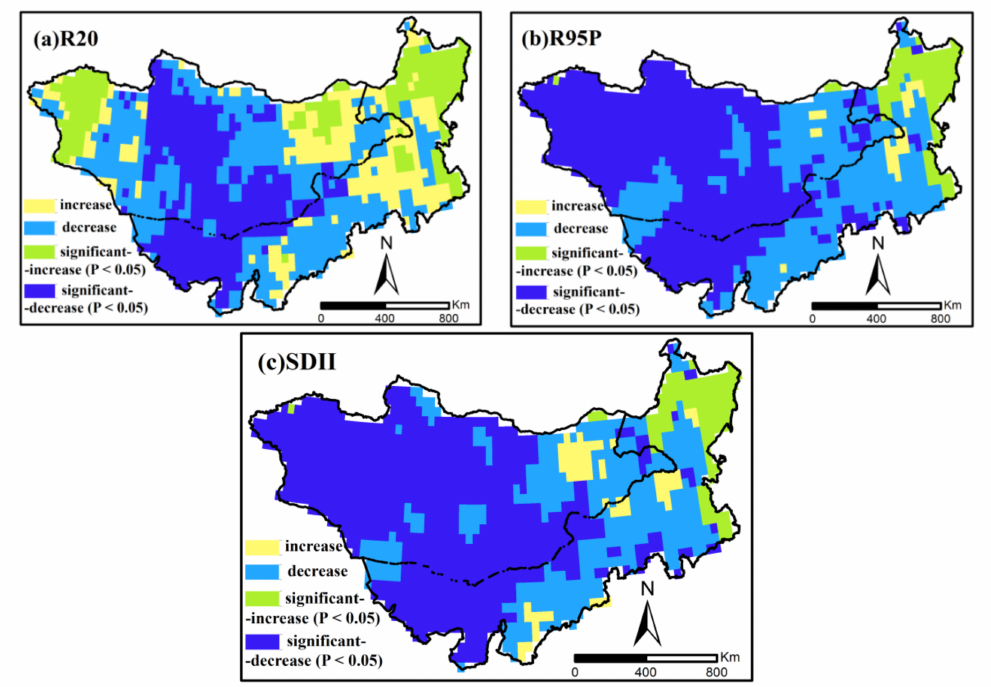
Figure 5. Spatial variation in the extreme precipitation index on the Mongolian Plateau over the last three decades.(Spatial trends of each extreme precipitation index, ( a ) R20: Number of moderate precipitation days, ( b ) R95P: Very wet days, ( c ) SDII: Annual mean rainy day precipitation